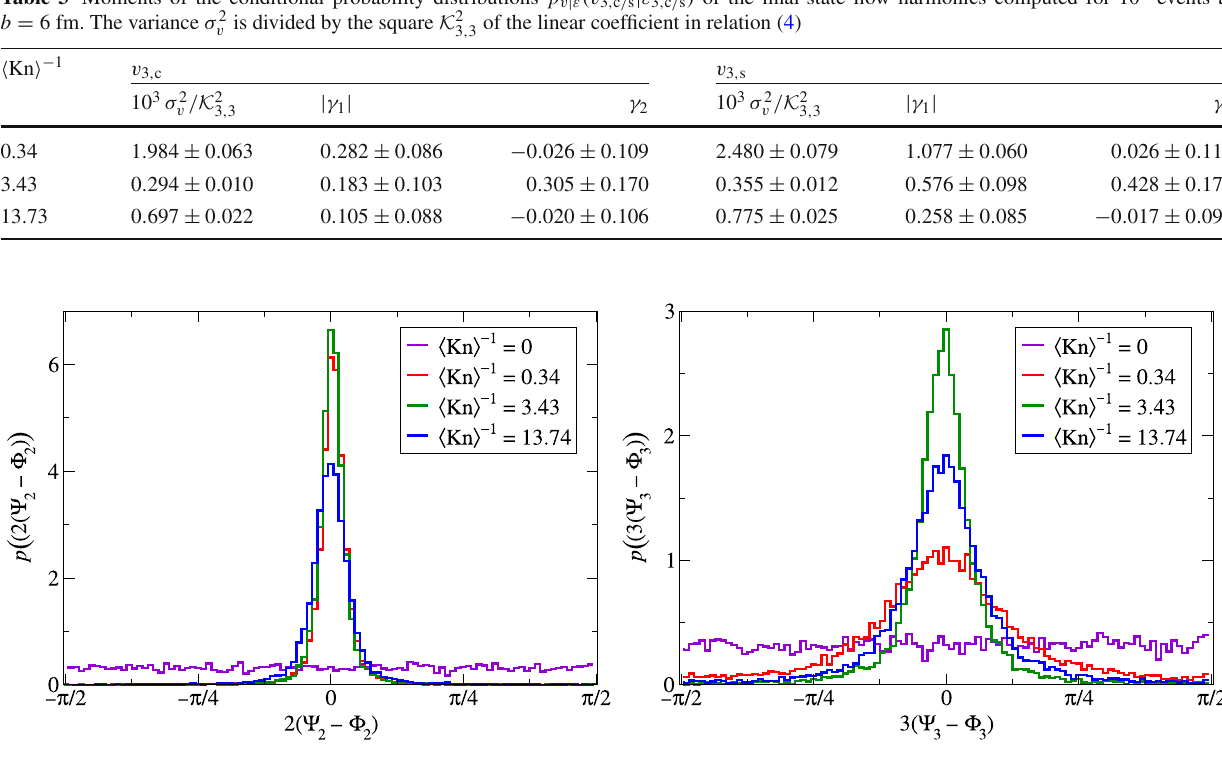
Fig. 6 Probability distributions of p ( 2 ((cid:5) 2 − (cid:4) 2 )) (left) and p ( 3 ((cid:5) 3 − (cid:4) 3 )) (right) for events at b = 6 fm for different (cid:3) Kn (cid:4) − 1 . The value (cid:3) Kn (cid:4) − 1 = 0 corresponds to the initial